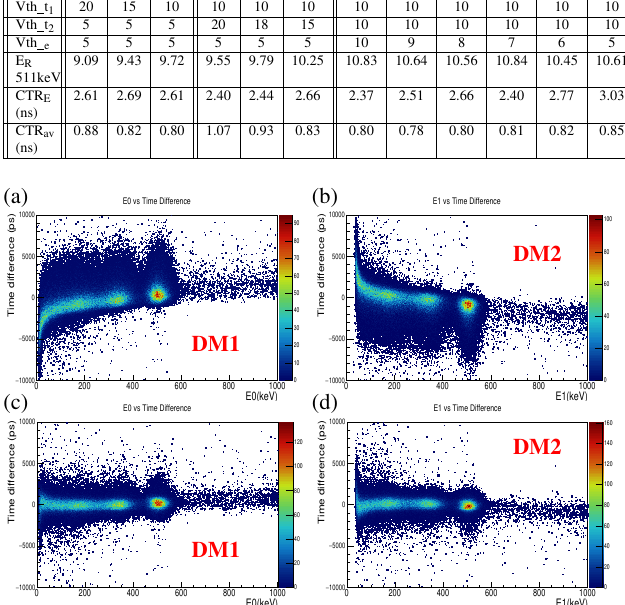
Characterisation of the TOFPET2 ASIC thresholds. Values of energy resolution at 511 keV peak and CTR (calculated by two different ways) are shown.